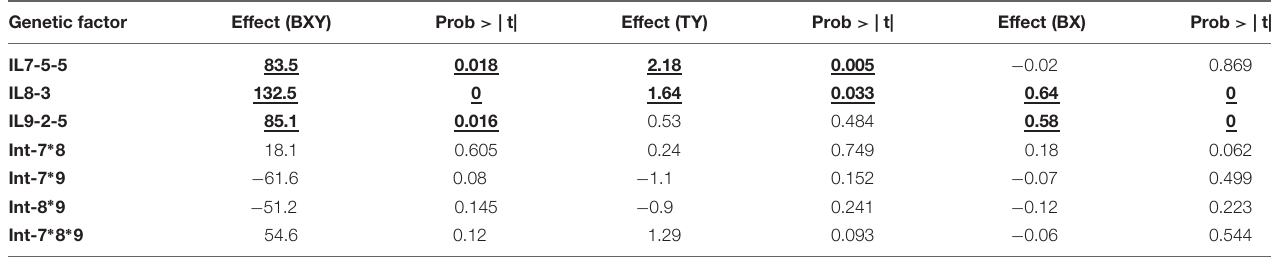
TABLE 2 | Phenotypic effects of pyramided introgressions and the interactions between them in the All-Heterozygous pyramid. Genetic